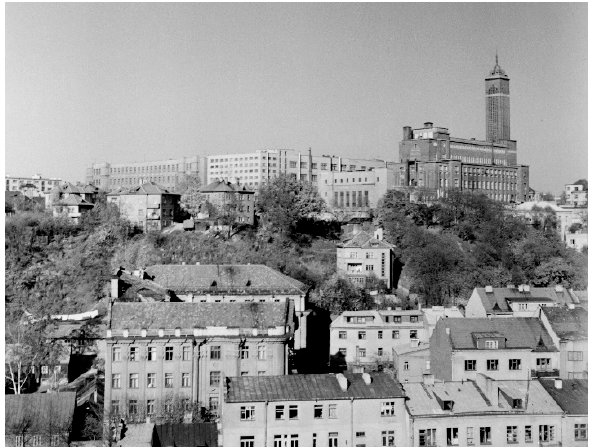
Figure 13. View of the wing along Astronomijos Street (source: Lithuanian Central State Archives).